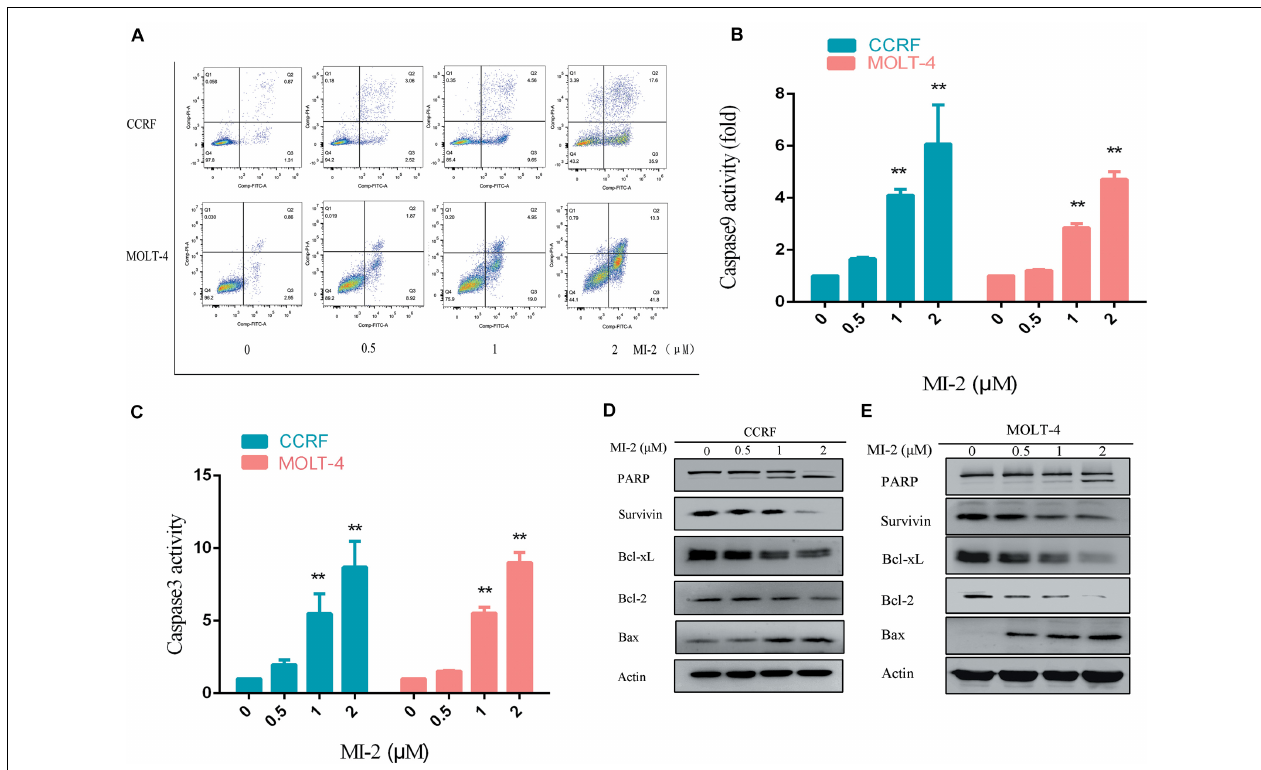
FIGURE 3 | MI-2 induced apoptosis of T-ALL cells in a dose-dependent manner. (A) The effect of MI-2 on cell apoptosis was analyzed by FACS. (B,C) CCRF and MOLT-4 were plated with the indicated concentration of MI-2 for 12 h. Caspase-9 and caspase-3/7 activity were assessed according to the manufacturer’s protocol. (D,E) Representative images of apoptosis-related protein were shown. ** P <